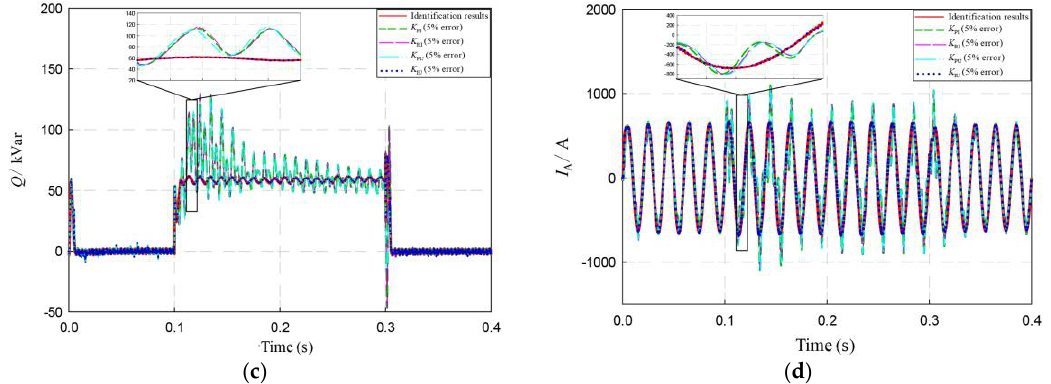
Figure 20. Analysis of parameter identification effect in case of phase A voltage sag under strategy Three: ( a ) DC bus voltage; ( b ) Active output power of the inverter; ( c ) Reactive output power of the inverter; ( d ) Grid current.